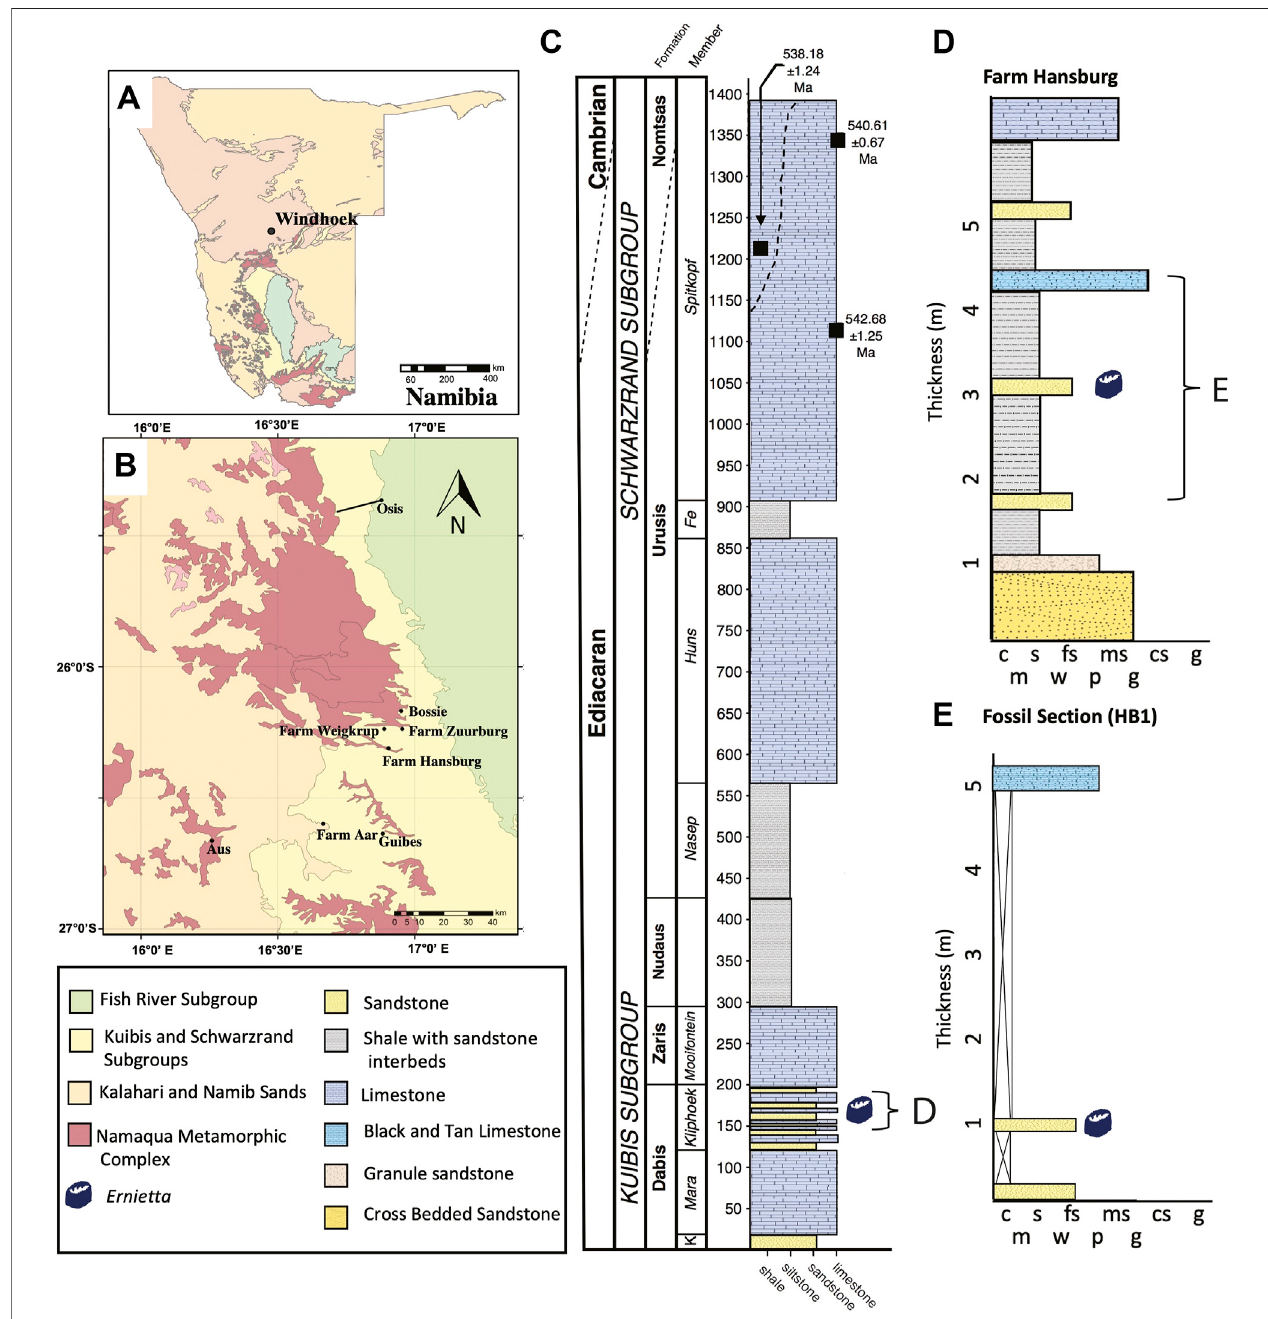
FIGURE 1 | Geologic Setting. (A) Map of Namibia showing the distribution of subgroups within the Nama Group. (B) Geologic map showing the study site, Farm HansburgandotherknownEdiacaranfossillocalitiesinsouthernNamibia. (C) StratigraphyoftheKuibisandSchwarzrandSubgroupsinthesouthernWitputsSubbasin. K-Kaines Member, Fe-Feldschuhhorn (D) Representative log of the stratigraphy at Farm Hansburg. (E) Stratigraphic log of the fossil section at Farm Hansburg where Ernietta slabs were recovered. (Adapted from Maloney et al., 2020).